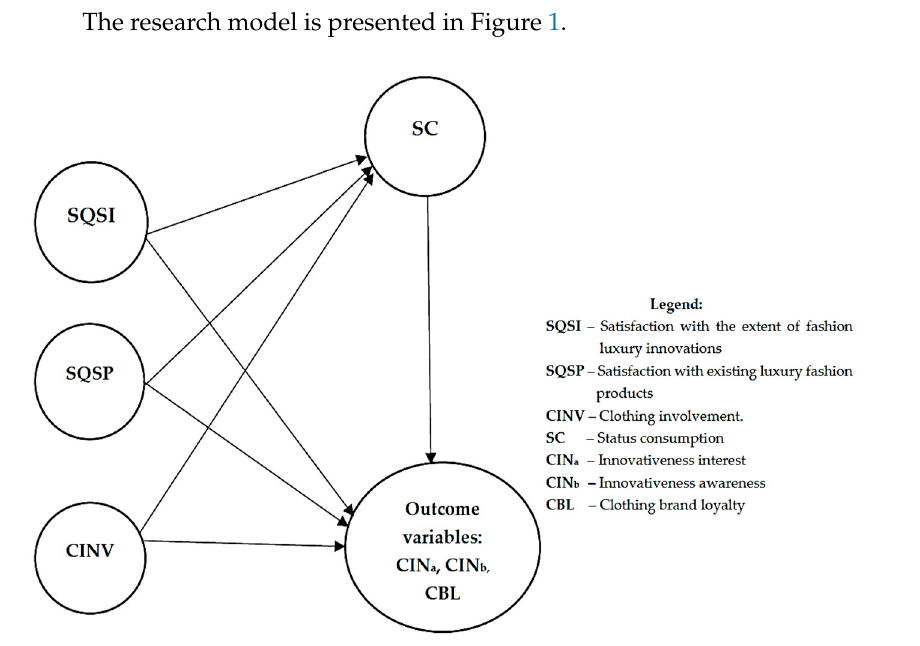
Figure 1. The research model.